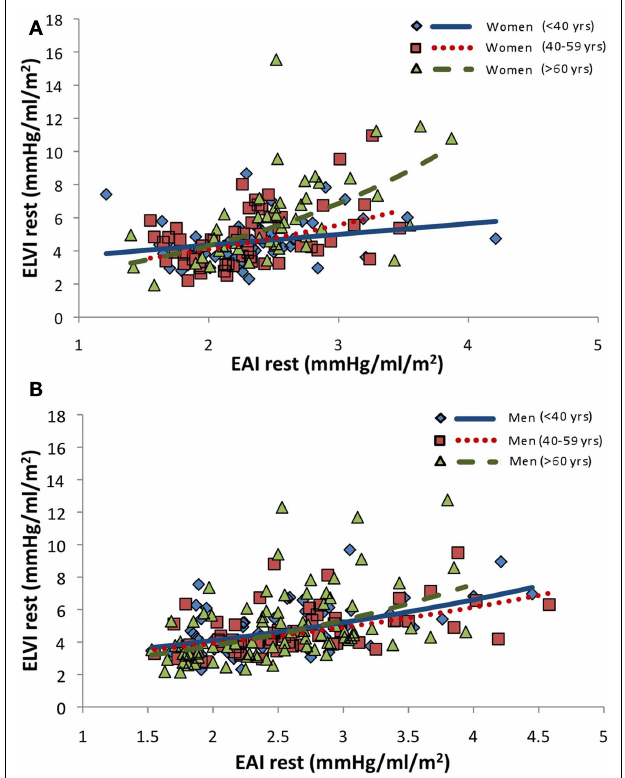
FIGURE 4 | Relationship between arterial (E A I) and left ventricular (E LV I) elastance indexed to body surface area in healthy men (A) and women (B) from the Baltimore longitudinal Study ofAging. Note the linear relationship between E A I and E LV I irrespective of age and gender (Chantler and Lakatta, unpublished